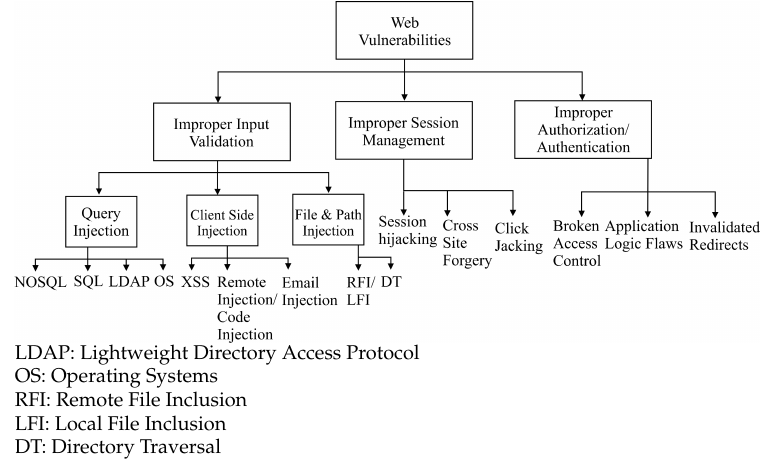
Figure 2. Types of web vulnerabilities [2].